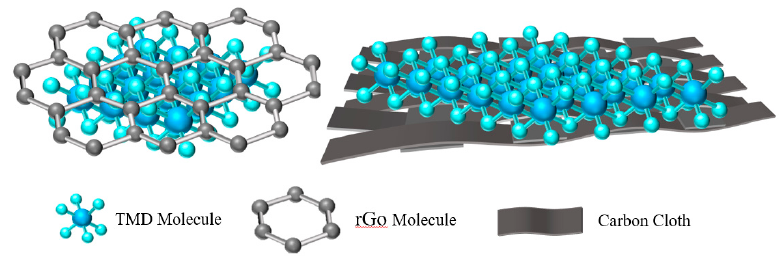
Figure 6. Modification of TMDs by Hybrid